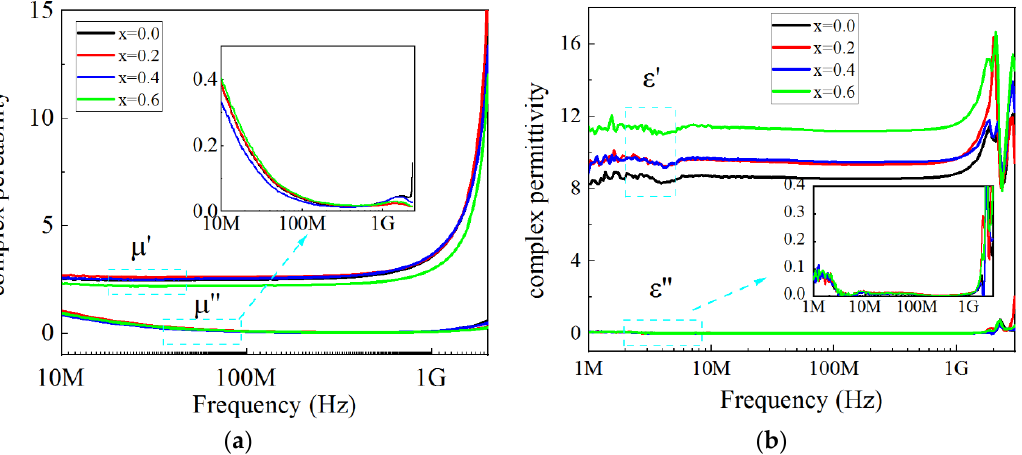
Figure 4. Complex magnetic permeability. ( a ) Complex dielectric permittivity ( b ) and samples with various x values.